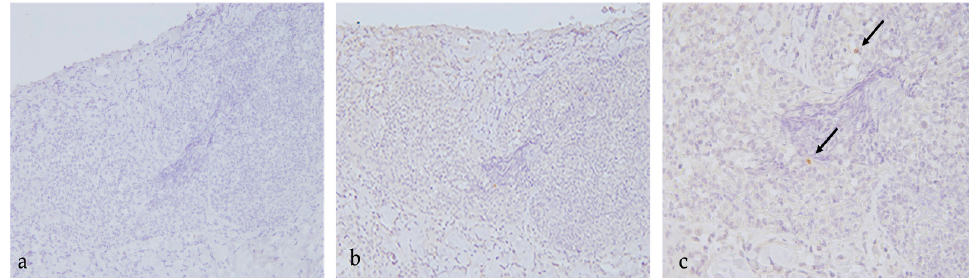
Figure 2. IHC on skin biopsy of the footpad ulcerative lesion using a rabbit polyclonal antibody raised against the FCV-F9 vaccine strain [37]. ( a ) (20X): negative control; ( b ) (20X), ( c ) (40X): positive cells. Arrows indicate positive